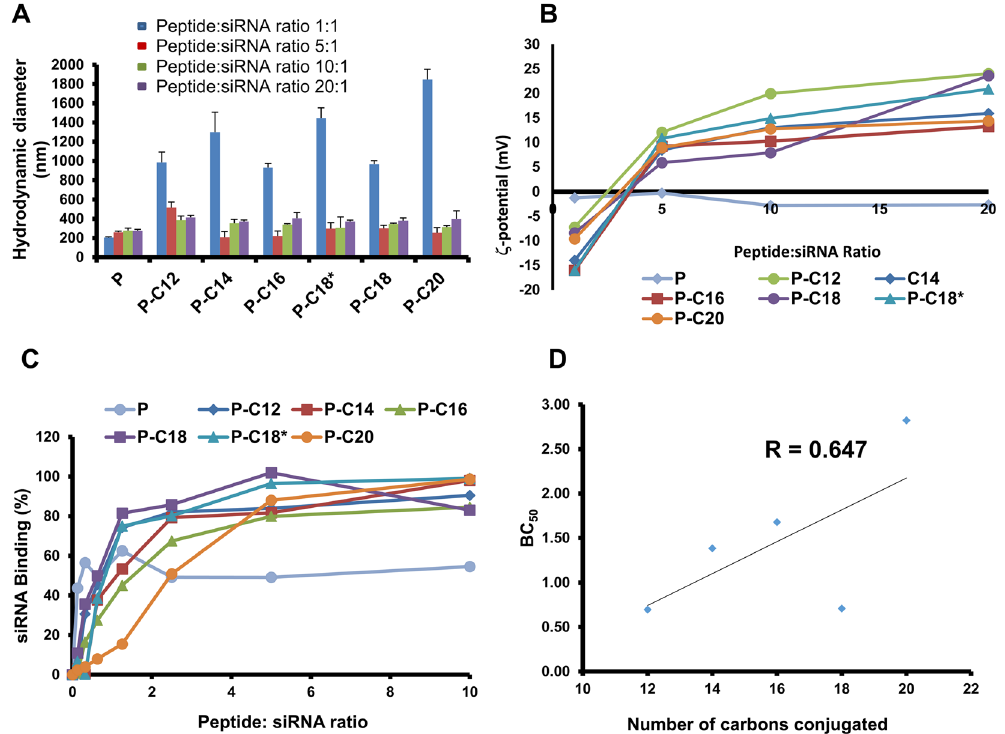
Figure 3. Size, ζ -potential, and binding affinity of designed peptides. ( A ) Hydrodynamic diameter of native peptide (CGKRK) and the fatty acid conjugated peptides, analyzed by light scattering. A significant drop in the size of particles with increasing the peptide:siRNA w/w ratio to 5:1 (N/P ≈ 6.8) indicates the complex formation; ( B ) ζ -potential of the unmodified and the fatty acid-conjugated peptides. A gradual shift to positive surface charge also indicates complex formation with modified peptides. Similar trend was not observed for unmodified CGKRK; ( C ) Representative graph of Binding affinity of the peptide library to scrambled siRNA, indicating the percentage of siRNA bound to the peptide in different peptide:siRNA w/w ratios. Complete binding was observed for all modified peptides at ratio of 5:1 (N/P ≈ 6.8); ( D ) Correlation between the peptide:siRNA complex ratios required for 50% binding (BC 50 ) and the size of the fatty acid conjugation. R = 0.647 indicated a moderate correlation; however, the correlation coefficient was not significant in Pearson correlation coefficient analysis.